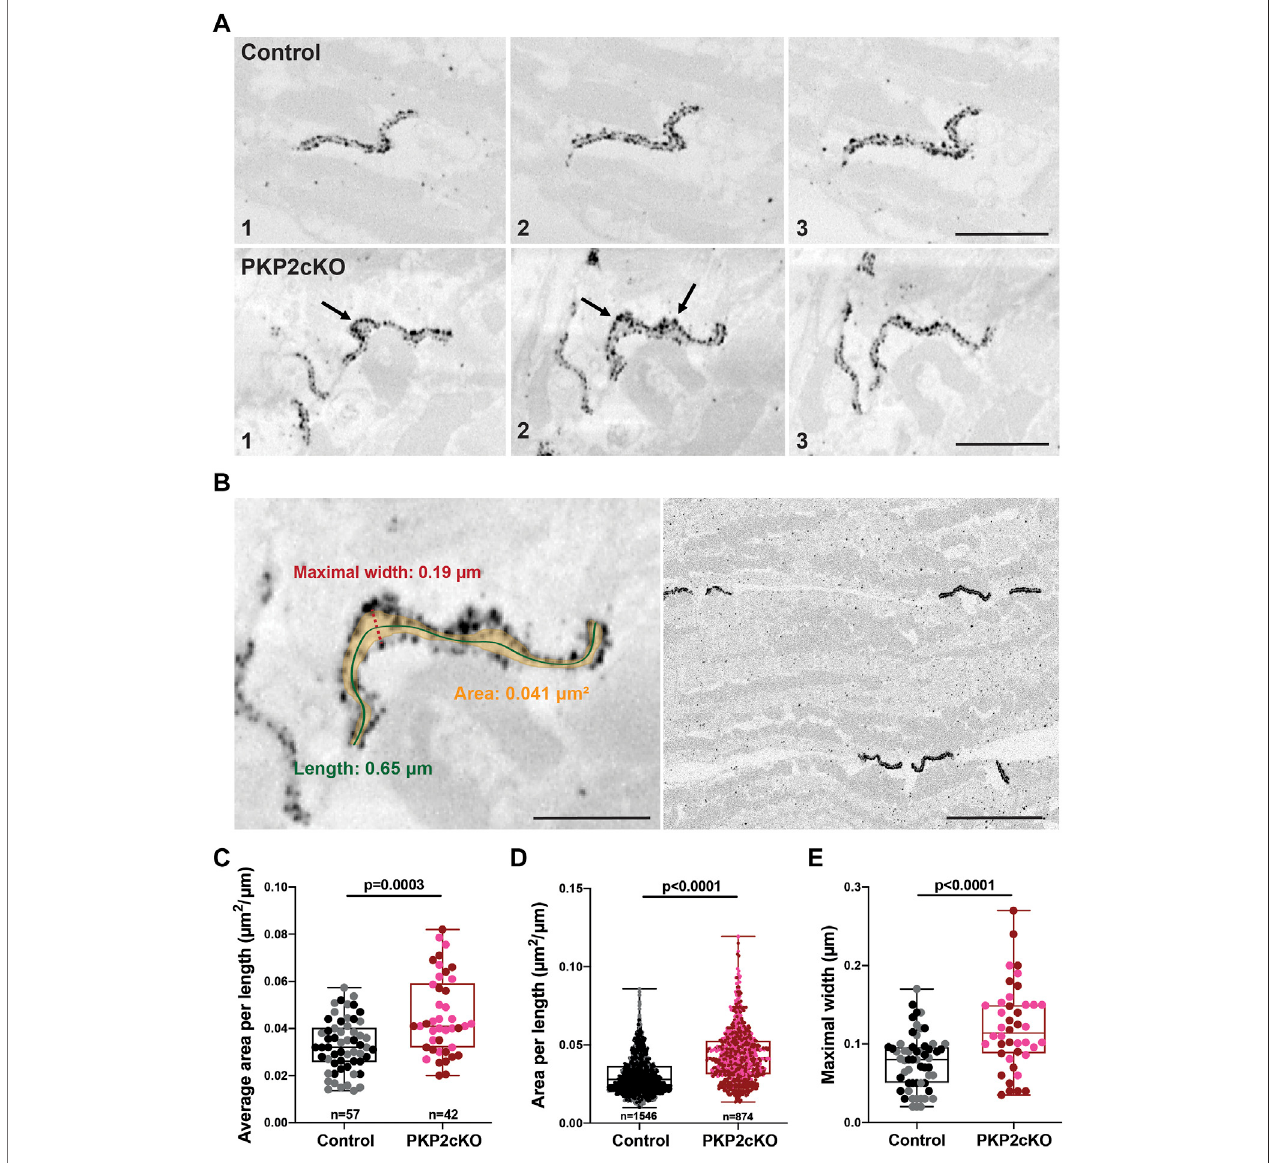
FIGURE 2 | Gap junction plaque separation in adult hearts of Plakophilin-2 conditional knock out mice (PKP2cKO). (A) Representative examples of 3D Connenxin43(Cx43) Immuno-ElectronMicroscopyimagesofaControl(toppanel) andPKP2cKO(bottom panel)heart. Thevariousframes(1 – 3)correspondtodifferent sectionlevelsofthesamesample.ArrowheadsdepictCx43hemichannels.Scalebar:0.5 μ m. (B) Leftpanel :Exampleofourmethodforquantifyingparametersshownin (C – E) . Scale bar: 0.2 µm. Right panel : Low magni fi cation example of multiple gap junction plaques in a Control heart sample. Scale bar: 0.5 µm. (C,D) Quanti fi cationof2Dsurfacebetweenintercalateddisc(ID)membranesincontrolandPKP2cKOhearts,correctedforIDlength(Areaperlength),averagedperID (C) and perindividualsection (D) . (E) MaximalwidthbetweenIDmembranes,perID. (C – E) :Control; n =57,PKP2cKO; n =42. (D) :Control; n =1,546,PKP2cKO; n =874.Data presented as box and whisker (min. – max.) plot. Data points corresponding to left ventricular (LV) and right ventricular (RV) samples represented in separate colors; Control LV; black, Control RV; grey, PKP2cKO LV; red, PKP2cKO RV; pink. Signi fi cance in (C,D) as per Mann-Whitney test, in (E) per Student ’ s t